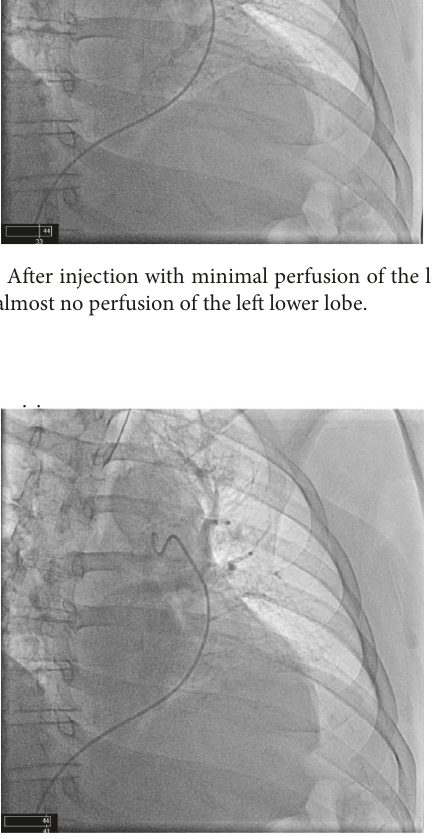
Figure4:Afterinjectionwithoutanysignificantperfusionoftheleft lung, especially in the lower